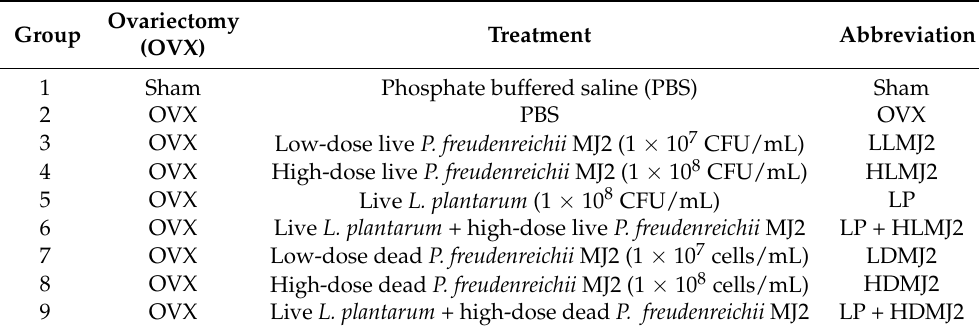
Table 2. Animal groups used in this